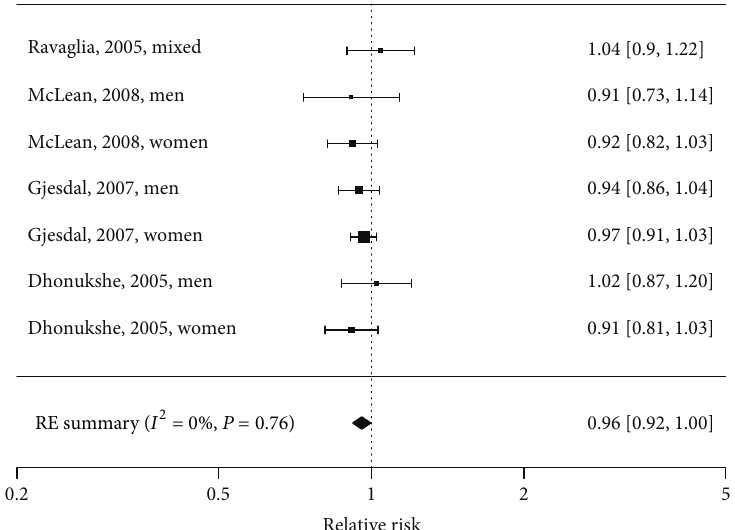
Figure 2: Forest plot of the association between vitamin B 12 (50pmol/L) and risk of fracture: Meta-Analysis of 4 observational studies.